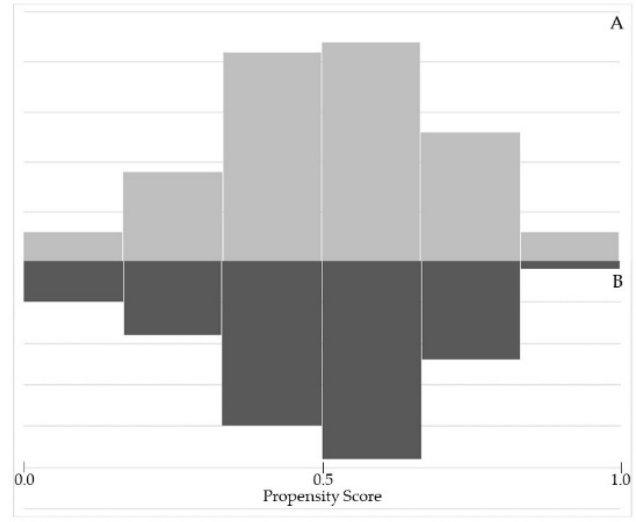
Figure 2. Assessing common support assumption required for propensity score matching procedure (A = RAPN group; B = OPN group).